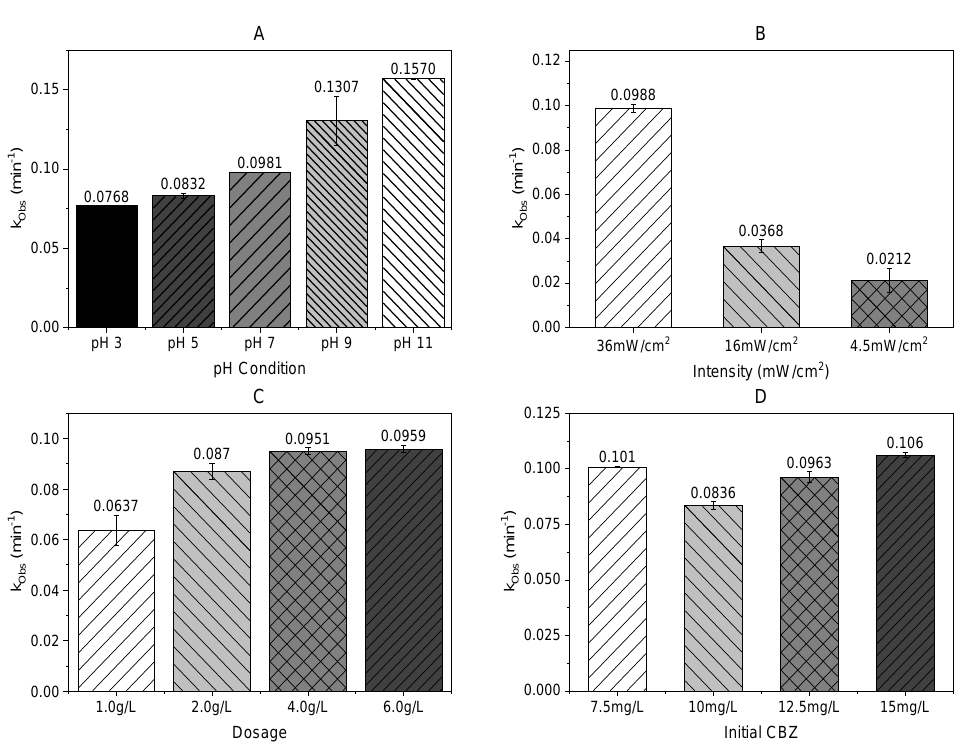
Figure 9. The k Obs , min −1 due to ( A ) varied pH conditions, ( B ) varied UV intensities, ( C ) varied dosages of composite, and ( D ) varied CBZ concentrations.